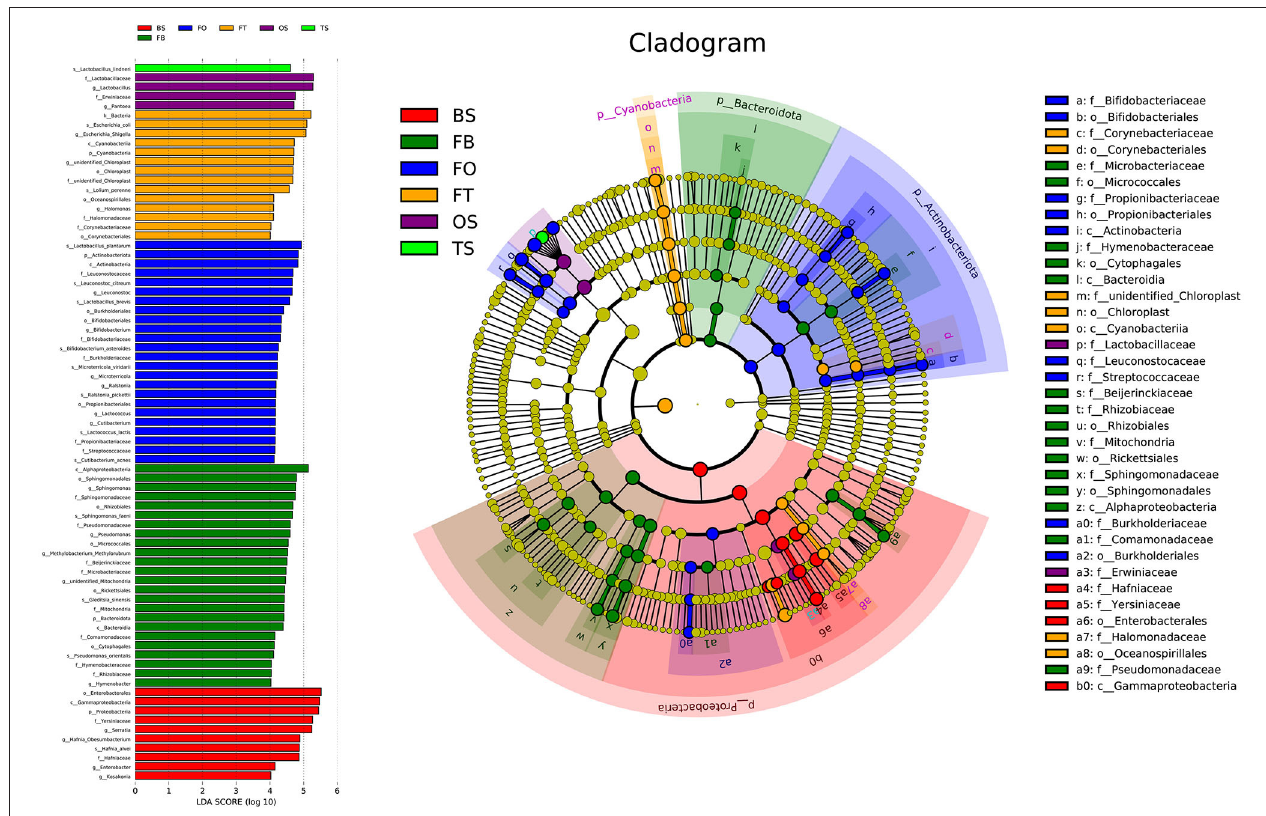
FIGURE 4 | Comparison of bacterial variations of faba bean, oat, and forage wheat before and after ensiling using the LEfSe online tool. FT, fresh forage wheat; FB, fresh faba bean; FO, fresh oat; TS, 100% forage wheat silage; OS, 100% oat silage; BS, 100% faba bean silage.